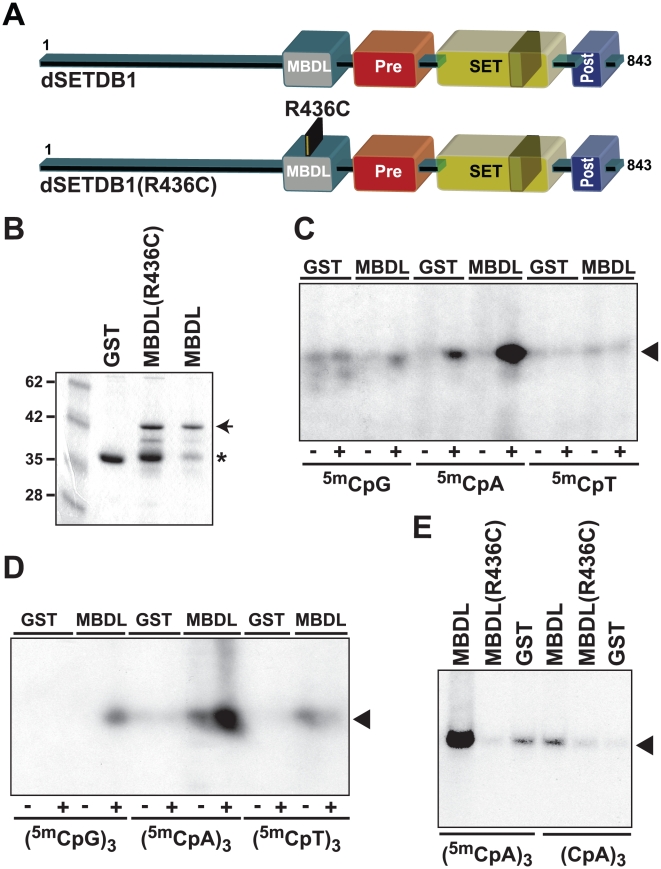
The MBDL of dSETDB1 binds methylated CpA motifs.(A) Schematic representation of dSETDB1 and the mutant dSETDB1(R436C), which contains the single amino acid exchange mutation arginine (R) to cysteine (C) at position 436. Rectangles mark the positions of the MBDL, Pre-SET domain (Pre), SET domain (SET), and Post-SET domain (Post). (B) Coomassie blue-stained SDS-PAGE gel detecting affinity-purified GST, the fusion protein consisting of GST, the MBDL of dSETDB1 (MBDL), and the GST-MBDL(R436C) [MBDL(R436C)] fusion protein. Recombinant proteins were expressed in Escherichia coli, purified with glutathione-agarose and subjected to SDS-PAGE. The positions and relative molecular weights of protein standards are indicated. The arrow marks the position of GST-MBDL and GST-MBDL(R436C), the asterisk the position of GST. The protein samples and amounts shown were used for the binding assays shown in (C-E). (C) Autoradiogram of in vitro protein–DNA interactions detecting the association of [32P]-radiolabeled, non-methylated (-) and methylated (+) DNA oligonucleotides containing 1 symmetrically methylated CpG-, CpA- or CpT motif. After proteins were incubated with DNA, retained DNA was purified, separated on native PAGE, and detected by autoradiography. (D) Autoradiogram of in vitro protein–DNA interaction assays as described in (C) except that methylated DNA oligonucleotides contained 3 symmetrically methylated CpA-, CpT-, or CpG motifs. (E) Autoradiogram of in vitro protein–DNA interaction assays as described in (C) except that GST, MBDL, and MBDL(R436C) and a DNA oligonucleotide containing 3 symmetrically methylated CpA motifs [(5mCpA)3] and the corresponding non-methylated DNA oligonucleotide [(CpA)3] were used. (C-E) The arrowhead marks the position of retained, radiolabeled DNA.